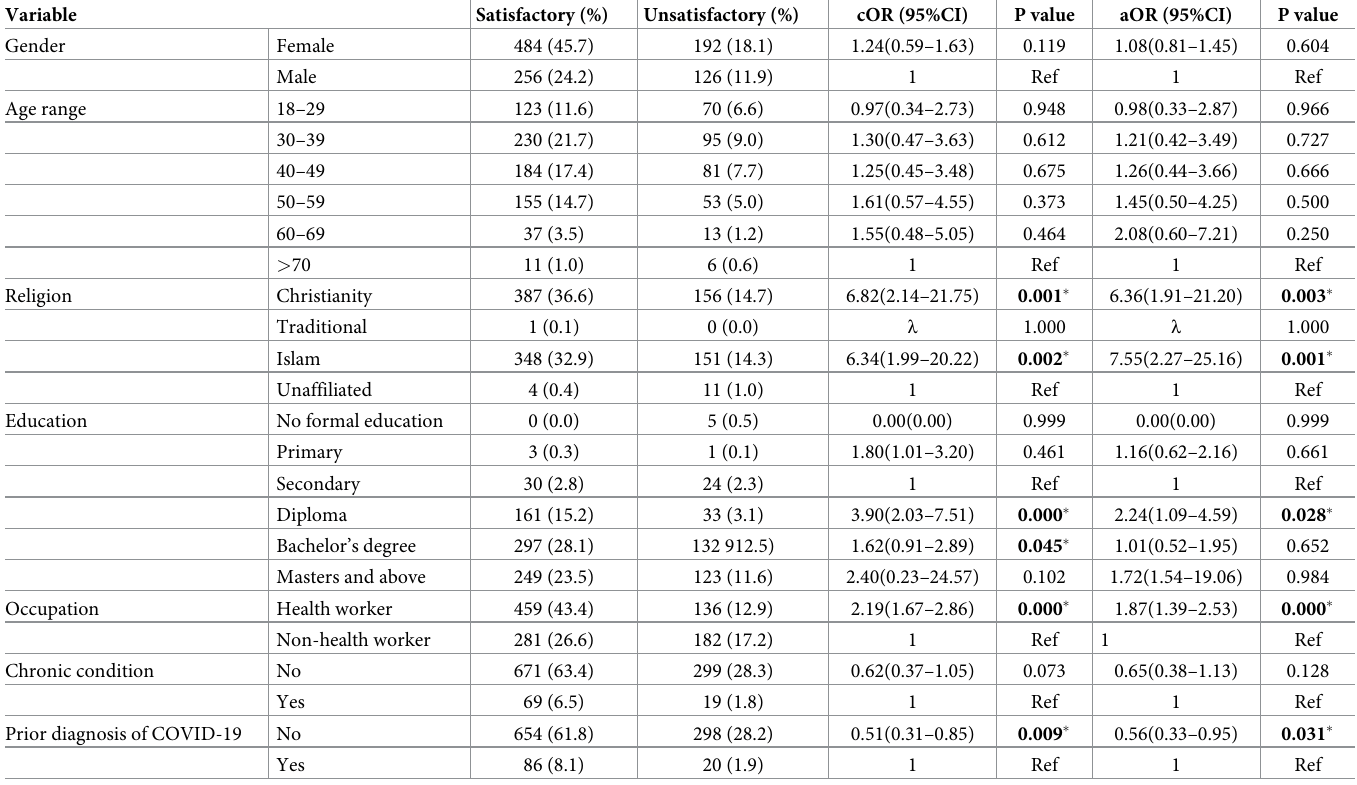
Table 3. Sociodemographic characteristics influencing the level of awareness of respondents towards the COVID-19 vaccination.